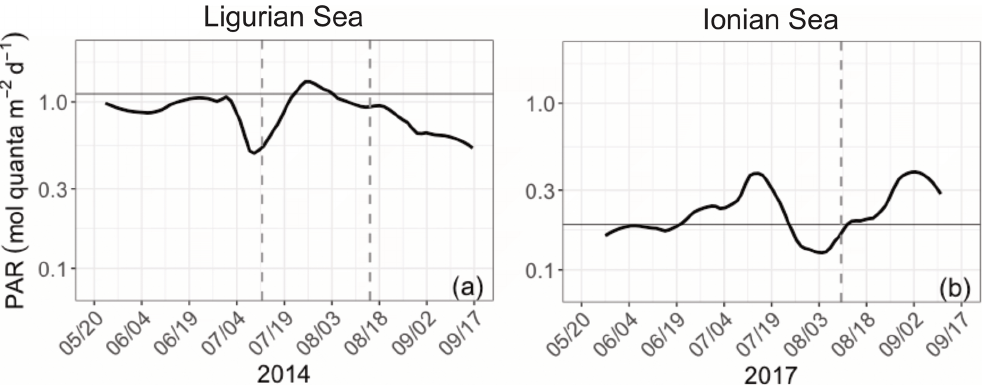
Figure 10. Time series of the daily integrated photosynthetically available radiation (PAR) at the SCM level in the Ligurian Sea (a) and the Ionian Sea (b) . The horizontal grey line shows the median of each time series. The dotted lines indicate the dates at which the values of c p in the SCM layer reach a minimum. Please note that the date format in this figure is